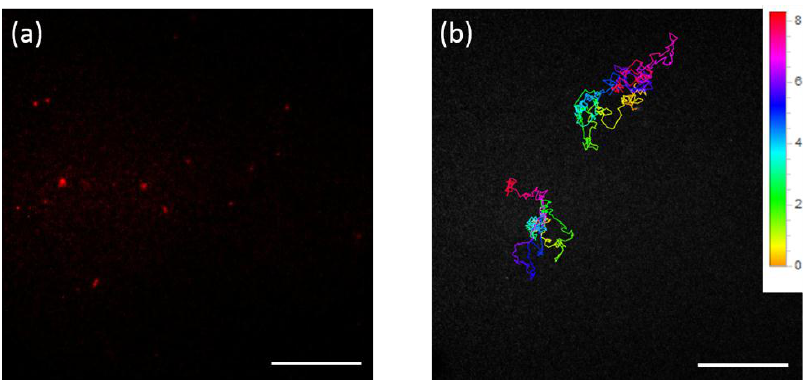
Figure 3. ( a ) Fluorescence image of the surface of a single cell treated with FND-HPG-Amp particles. Bright red spots indicate the fluorescence from FNDs; ( b ) Molecule trajectories of two FND-labeled IL-18R α recorded for ca . 8 s. The color code of the trajectory shows the time course, as indicated on the right side. Scale bar shows 10 µ m. Movies are provided in supplementary material.